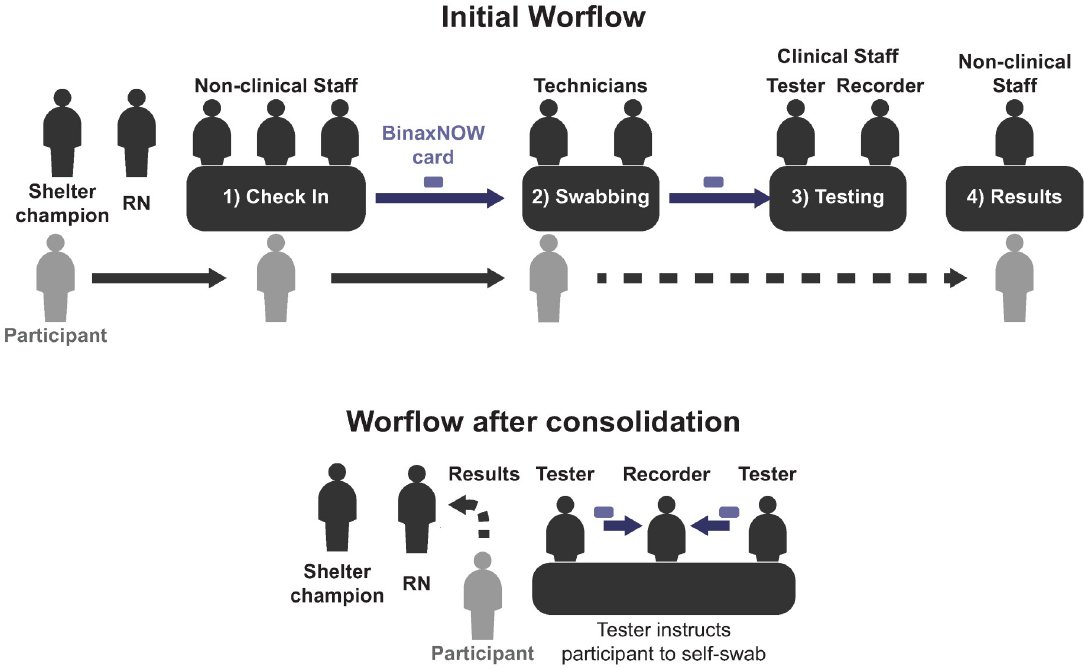
Fig 1. Initial and post-consolidation of rapid SARS-CoV2 antigen testing at homeless shelters, San Francisco, 2021. Initial BinaxNOW Shelter Pilot workflow: non-clinical staff checked in participants and labeled testing materials (1). Laboratory technicians then swabbed the participants (2) and handed the sample to a testing team (3) who ran the assay. Participants left the testing area and could return to get their results from a non-clinical staff (4). The shelter champion helped recruiting participants and the registered nurse (RN) assessed symptoms and disclosed positive results and conducted case investigation. BinaxNOW Shelter Pilot workflow after consolidation: To streamline the process and reduce staff and supplies needed, Testers registered, checked-in, instructed participants to self-swab and handed assays to the Recorder. The shelter champion helped recruiting participants and the registered nurse (RN) assessed symptoms and disclosed positive results and conducted case